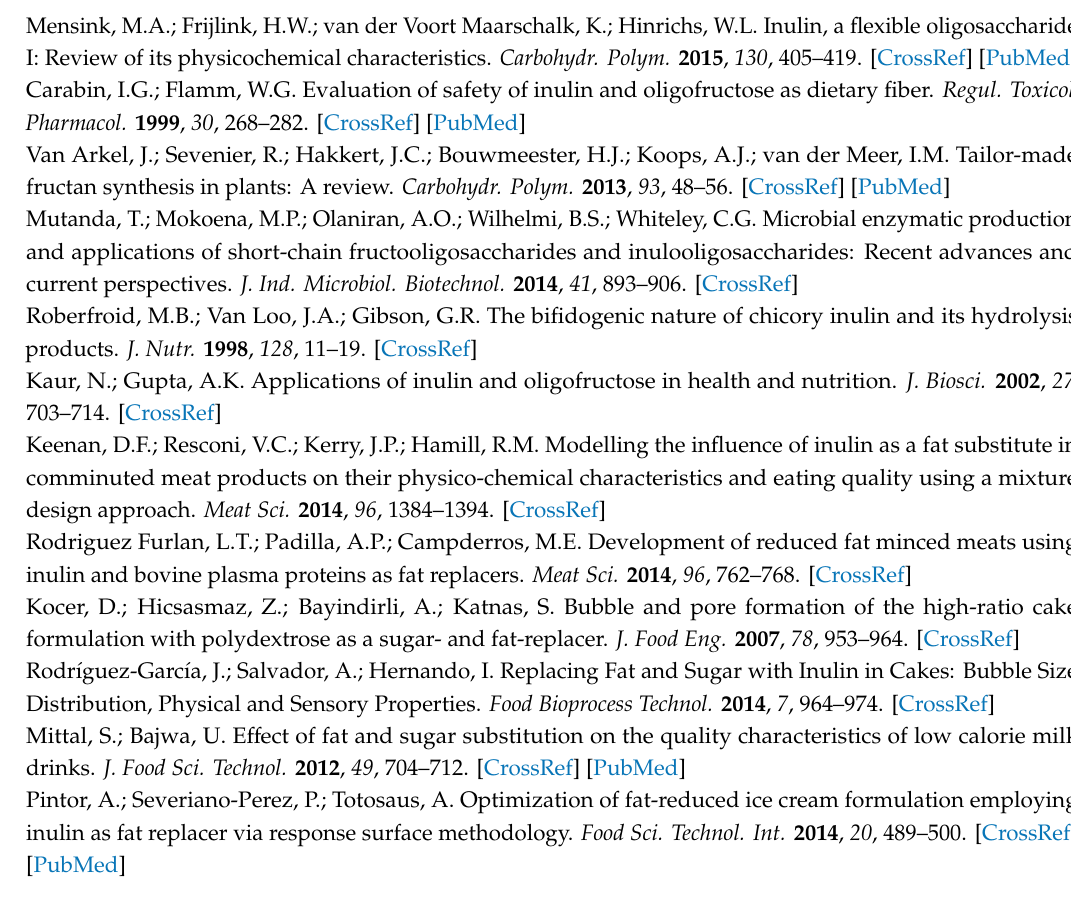
Figure S1: Periodate oxidation of inulin UV monitoring of the periodate oxidation of inulin reaction kinetic. Figure S2: 1 HNMR spectra of Oxi5. Figure S3: 1 HNMR spectra of Oxi10. Figure S4: 1 HNMR spectra of Oxi20. Figure S5: 1 HNMR spectra of Oxi30. Figure S6: 1 HNMR spectra of inulin-tBC. Figure S7: 13 CNMR spectra of inulin. Figure S8: 13 CNMR spectra of oxidized